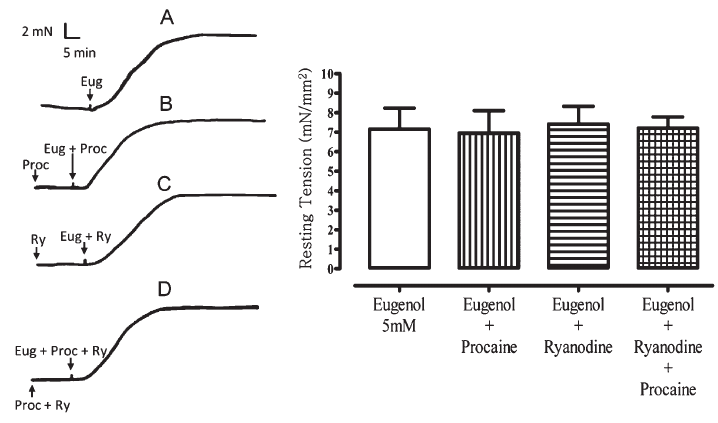
Figure 3. Effect of eugenol (Eug) on the resting tension of atria trabeculae of the rat in the absence ( A ) and in the presence of procaine (Proc) ( B ), ryanodine (Ry) ( C ) or both, procaine and ryanodine ( D ). The experiments were carried out in calcium-free Ringer solution. No significant differences in force were observed among groups (P . 0.05, ANOVA followed by the t -test; n=6).